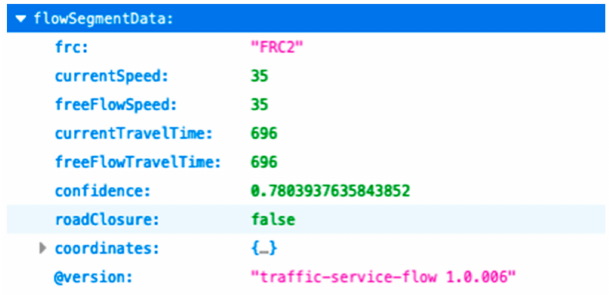
Figure 10. The response from TomTom Digital Maps server.